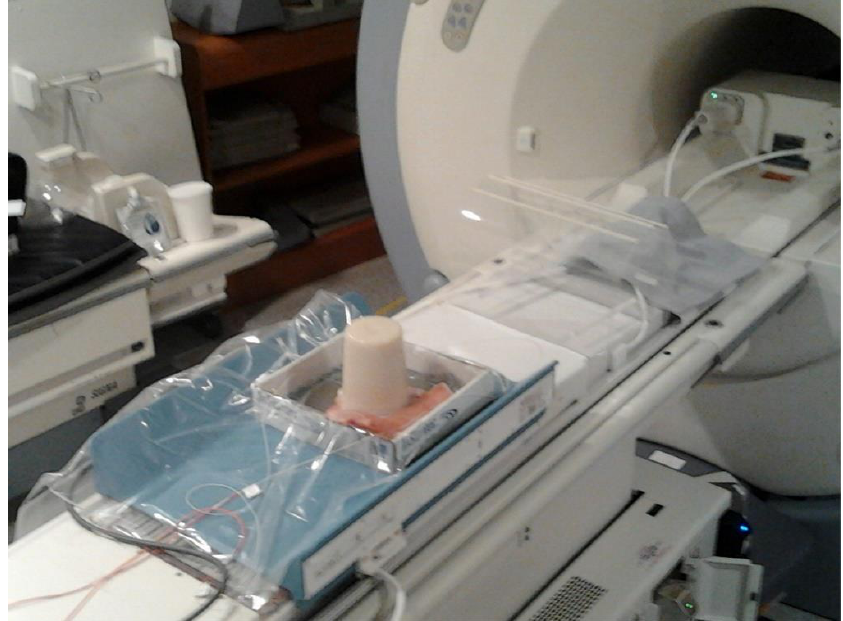
Figure 2. The realized configuration: the daily quality assurance (DQA) phantom over a skin portion. Although barely noticeable, the gel pad was placed under the skin to ensure acoustic coupling between the ExAblate bed and skin. In the left area of the image, the two interferometric probes are visible.